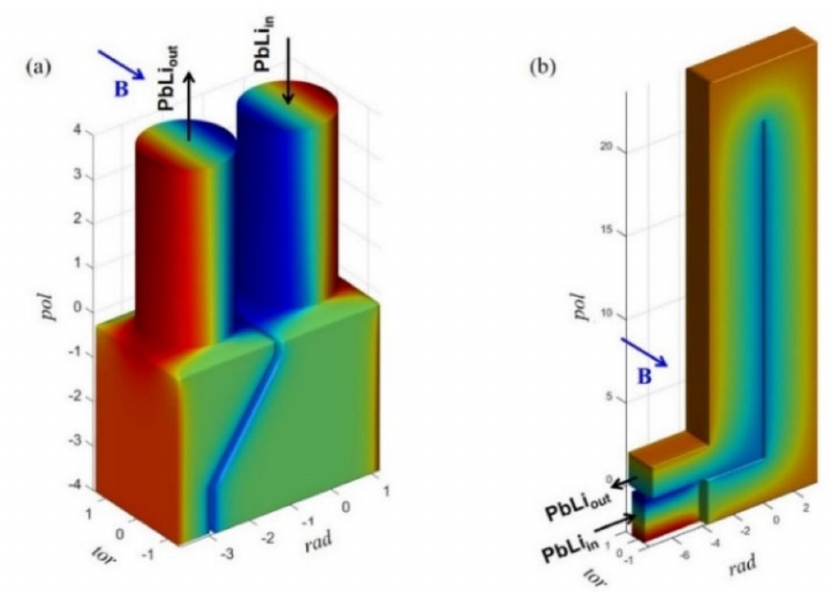
Figure 2. Examples of application of asymptotic methods for the study of pressure-driven MHD flows in ( a ) a DCLL geometry proposed in [16] and in ( b ) a model geometry for a modular DCLL, as shown in [17]; contours of electric potential are plotted on the fluid–wall